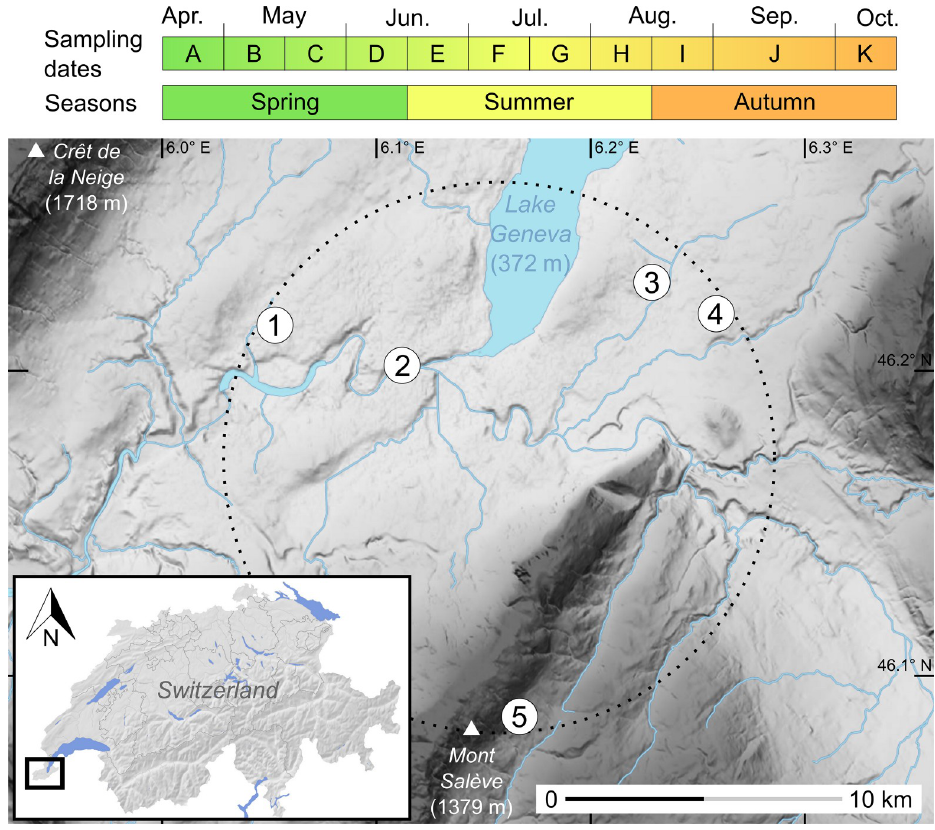
Fig 1. Sampling dates and map of the five colonies of long-eared bats studied in the Geneva region. Topographic slopes are shaded from pale (flat) to dark grey (steep). The dotted circle represents a virtual 10 km-radius area encompassing all the five sampled colonies: (1) Satigny, (2) pont Butin, (3) Choulex, (4) Presinge and (5) Sappey. The inset (lower left) provides a location map of the study area near Lake Geneva in southwestern